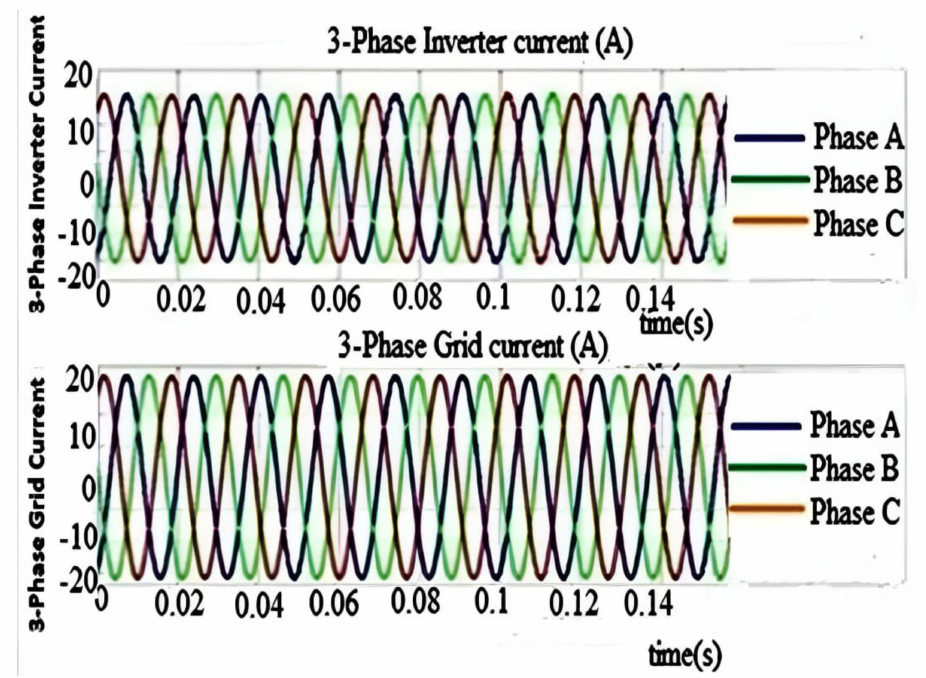
Figure 9. Low-load fuzzy-PI controller of the three-phase inverter and grid